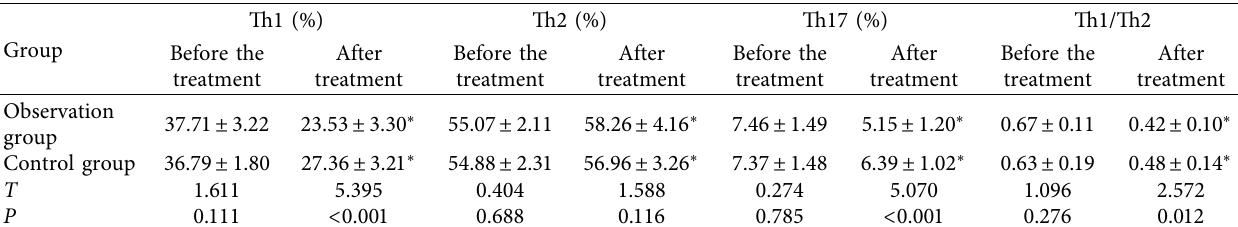
After Before the treatment treatment